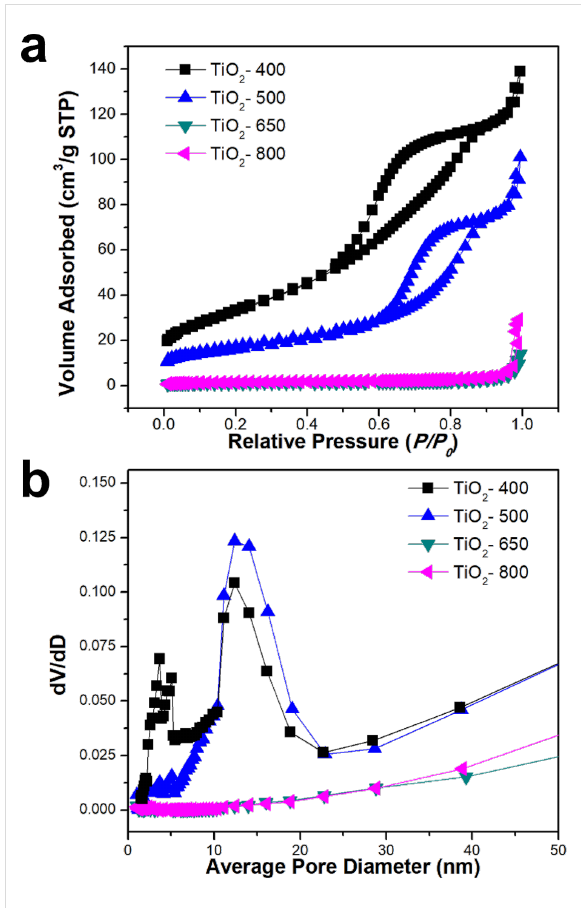
Figure 5: (a) N 2 adsorption/desorption isotherm and (b) pore size dis- tribution of TiO 2 particles calcined at different temperatures ( ≈ 400–800